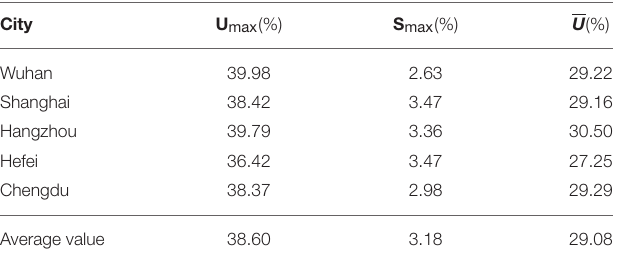
TABLE 8 | Analysis on the optimal results for the five selected